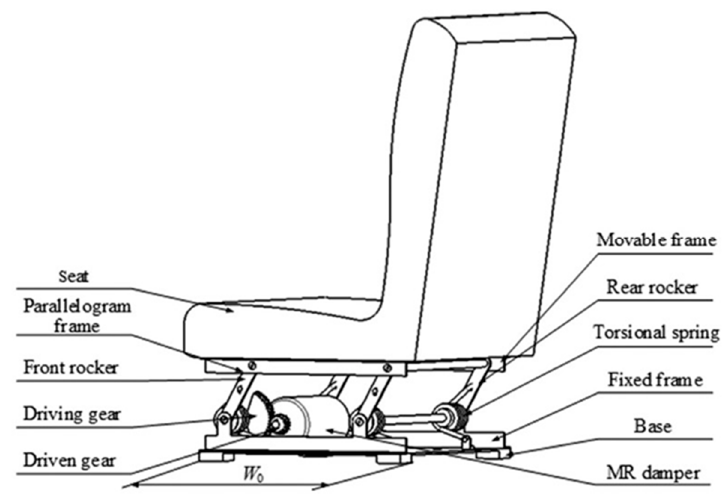
Figure 3. Semiactive seating system vibration controls with a magnetorheological (MR) damper [14].